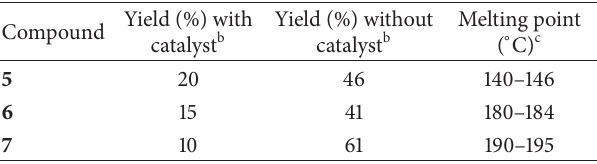
Table 1: Production of boron-diindolylmethanes assisted by mi- crowave a